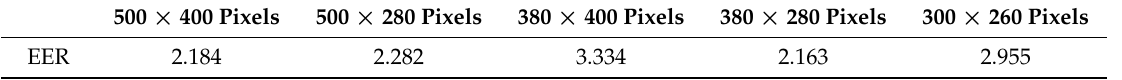
Table 5. Comparisons in recognition accuracies according to ROI crop size (unit: %).